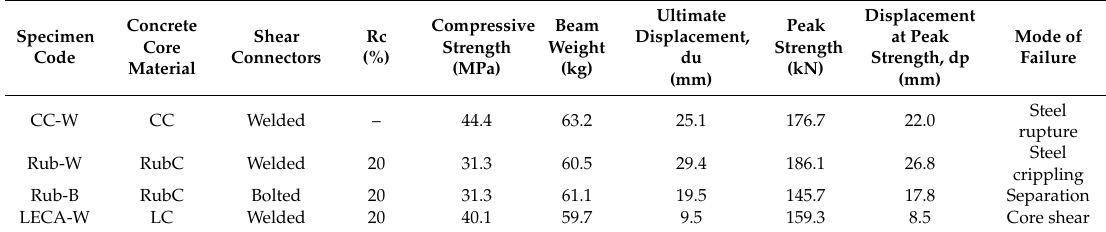
Table 2. Cyclic test results.